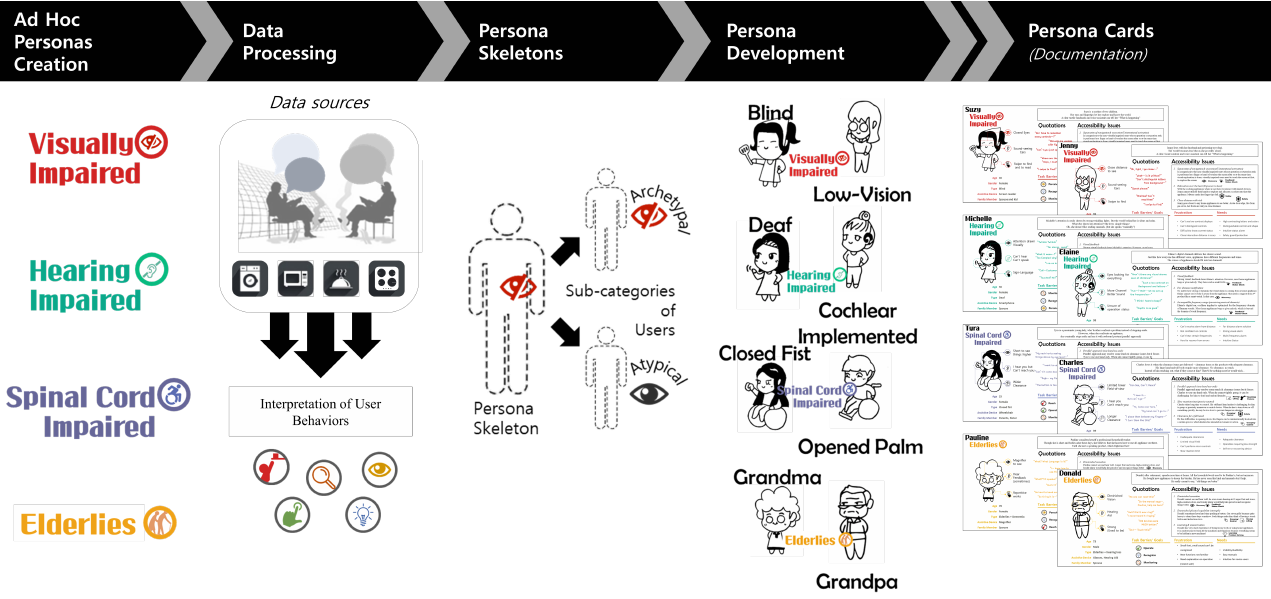
Figure 2. The flow of persona creation borrowed from Pruitt and Adlin